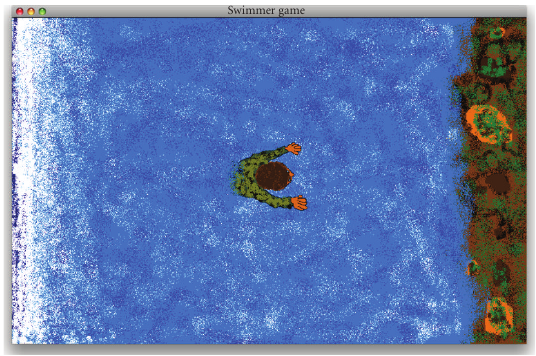
Figure 19: Swimmer’s game user